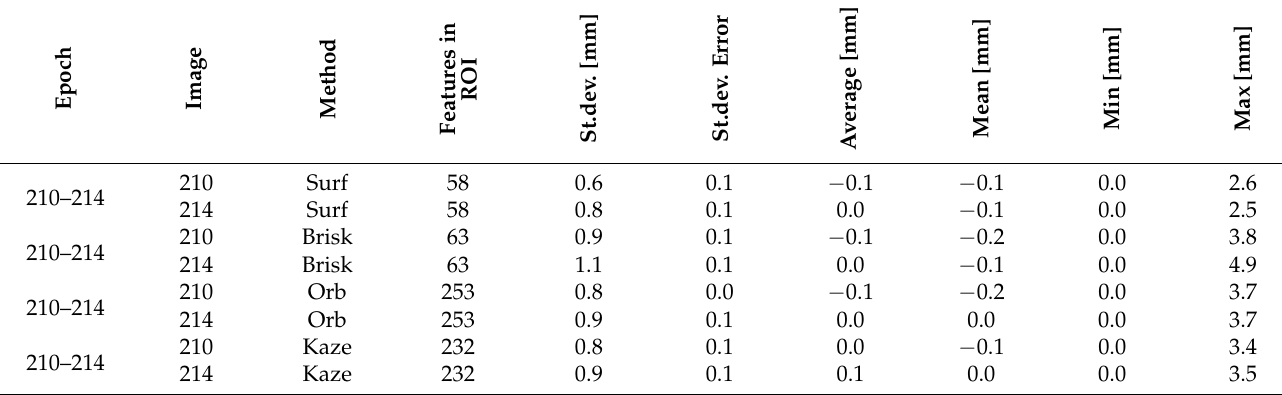
Table 4. Usable features and statistics of calculated data from them.